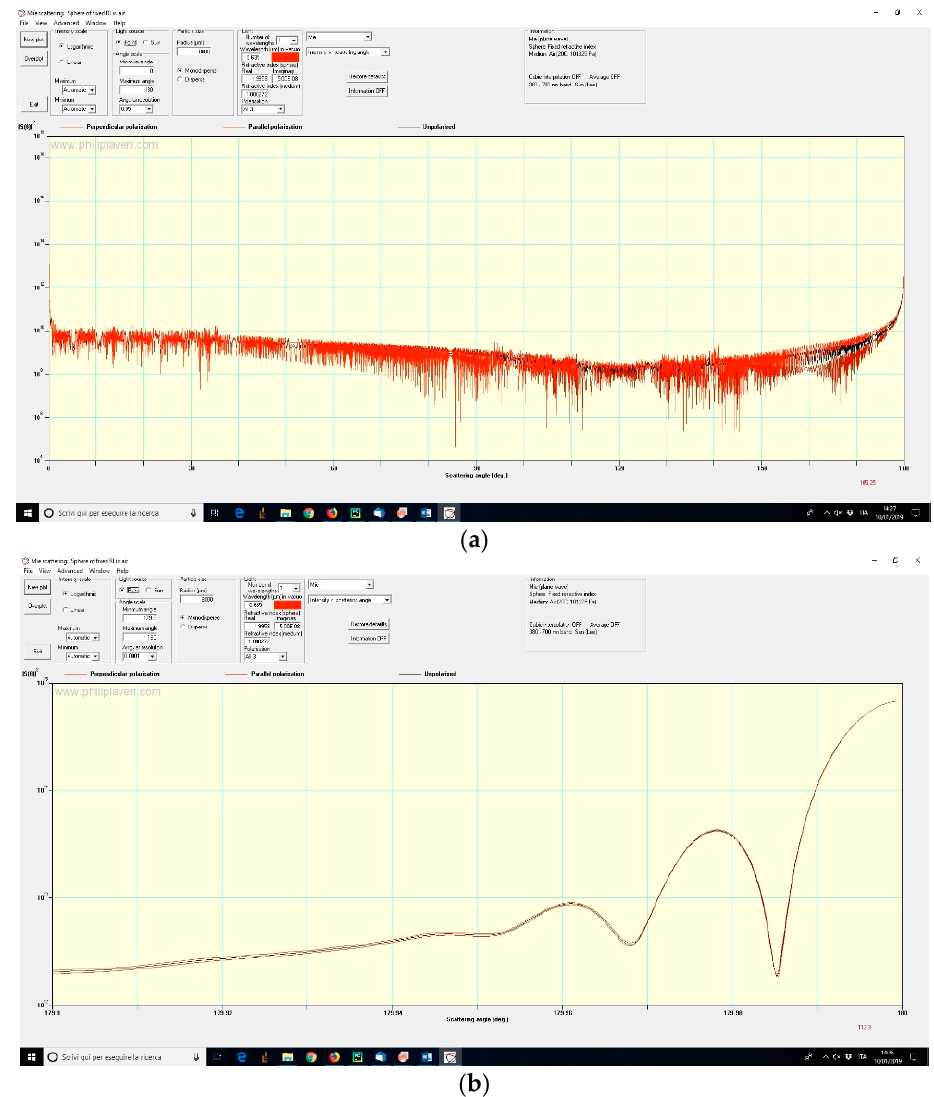
Figure 9. (MiePlot software). Replica of simulation conditions (same as Figure 8); in ( a ) the whole angular range is represented, while in ( b ) there is an emphasis on near-180° region (in logarithmic scale).